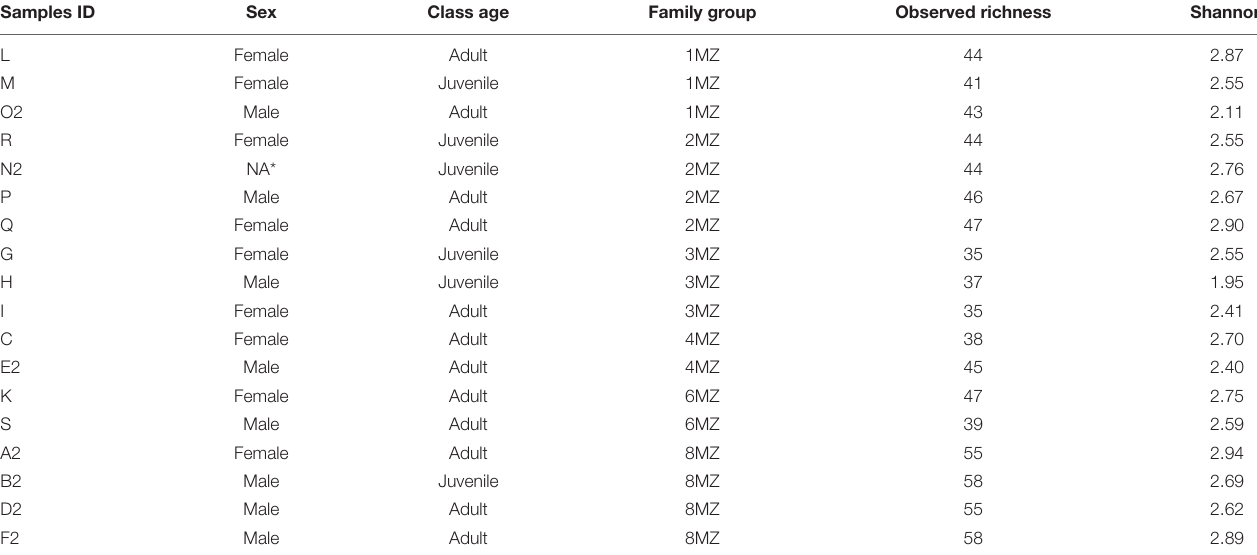
TABLE 1 | Description of each indri individual including sex, class age (Adult, > 6 years; Juvenile, < 6 years; NA*, not available) and family group, bacterial observed richness, and bacterial Shannon index values. Samples